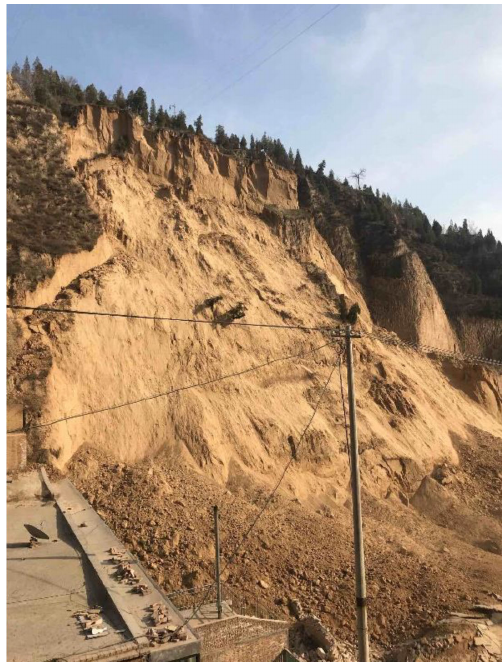
Figure 1. A cracking–sliding failure that occurred in Shilou County of Shanxi Province on 10 March 2018 (36 ◦ 59 (cid:48) 54.76 (cid:48)(cid:48) N), 110 ◦ 50 (cid:48) 48.54 (cid:48)(cid:48)